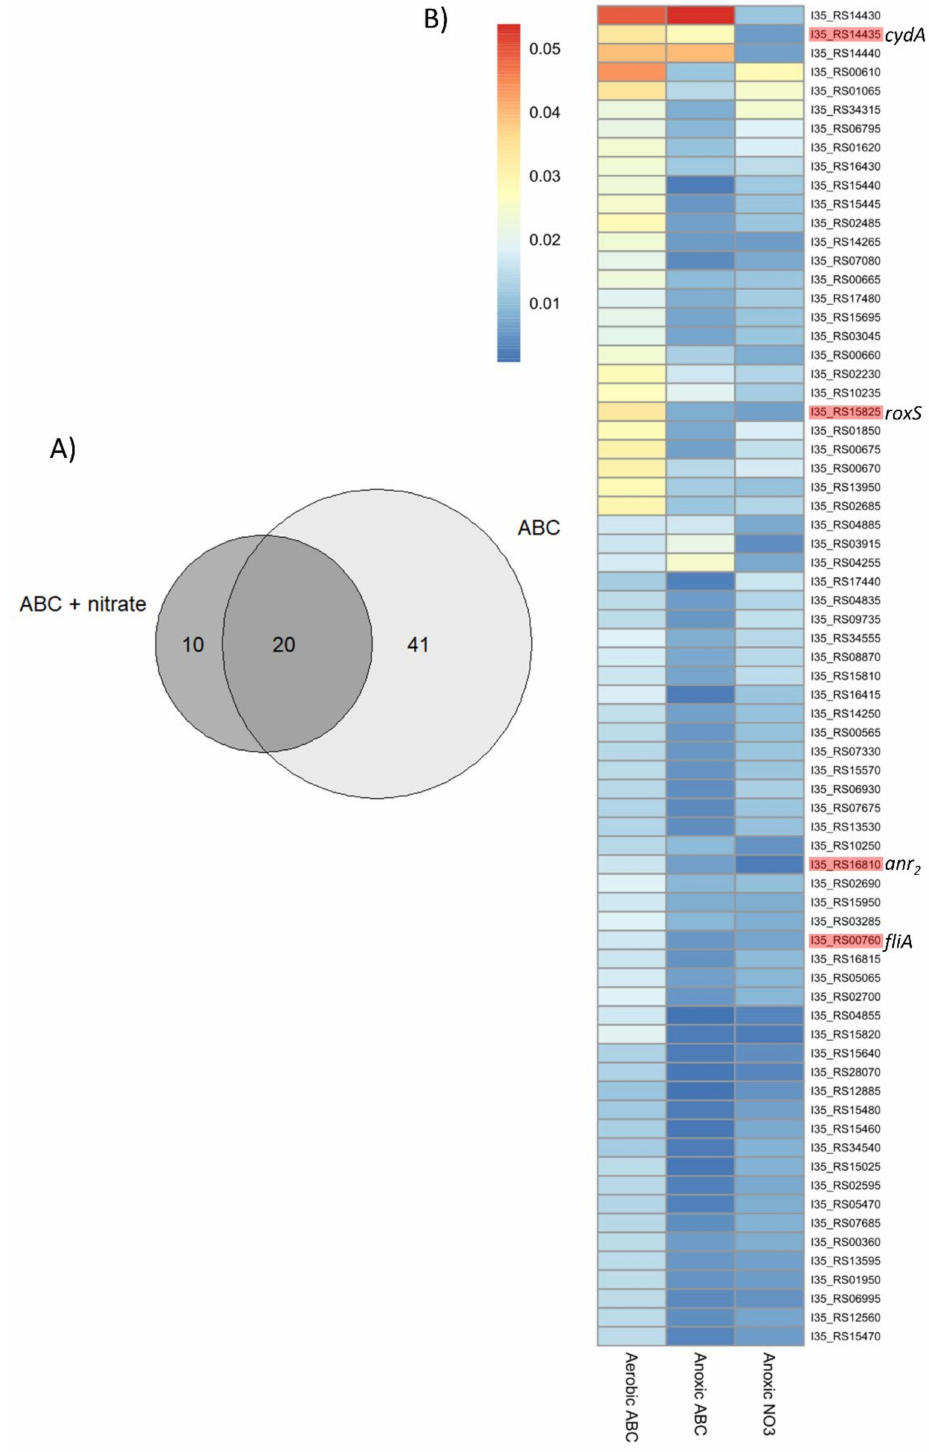
Figure 2. Tn-seq fitness analysis. ( A ) Venn diagram of unique and shared potential fitness deter- minants for the anoxic survival in ABC and ABC supplemented with 10 mM NaNO 3 . ( B ) Heat map based on the unique insertion density (UID) of the 71 potential fitness determinants in anoxic condition (ABC or ABC with 10 mM NaNO 3 ). Scale shows the values of the UID for the 71 fitness determinants as a color scale. Genes highlighted in red were selected for targeted gene deletions, and their respective gene name is indicated on the right-hand